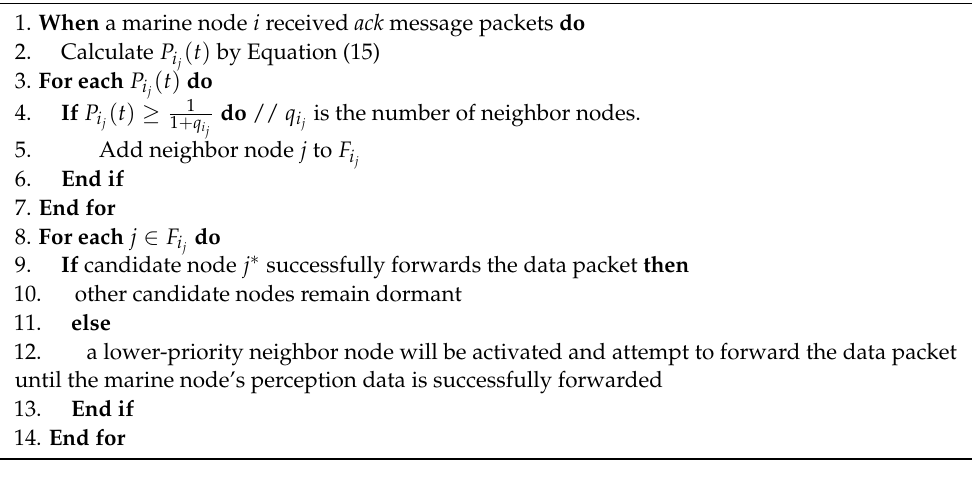
Algorithm 2 Scheduling of Candidate Forwarding Nodes